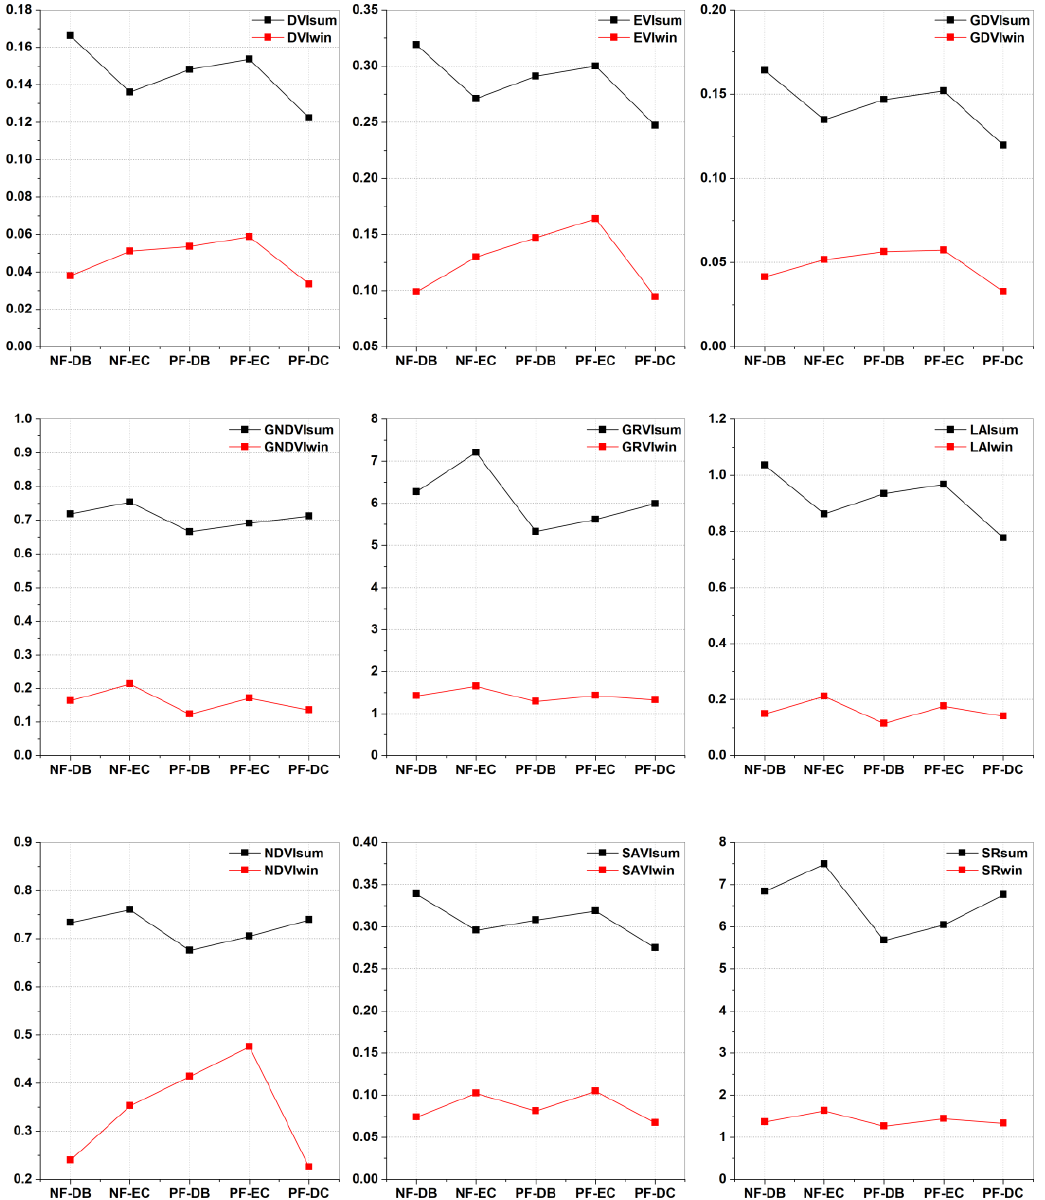
Figure 4. Mean vegetation indices of five forest types. Difference vegetation index (DVI); enhanced vegetation index (EVI); green difference vegetation index (GDVI); green normalized difference vegetation index (GNDVI); green ratio vegetation index (GRVI); leaf area index (LAI), normalized difference vegetation index (NDVI); simple ratio vegetation index (SR); soil-adjusted vegetation index (SAVI). The suffix sum represents VI in summer and suffix win represents VI in winter.